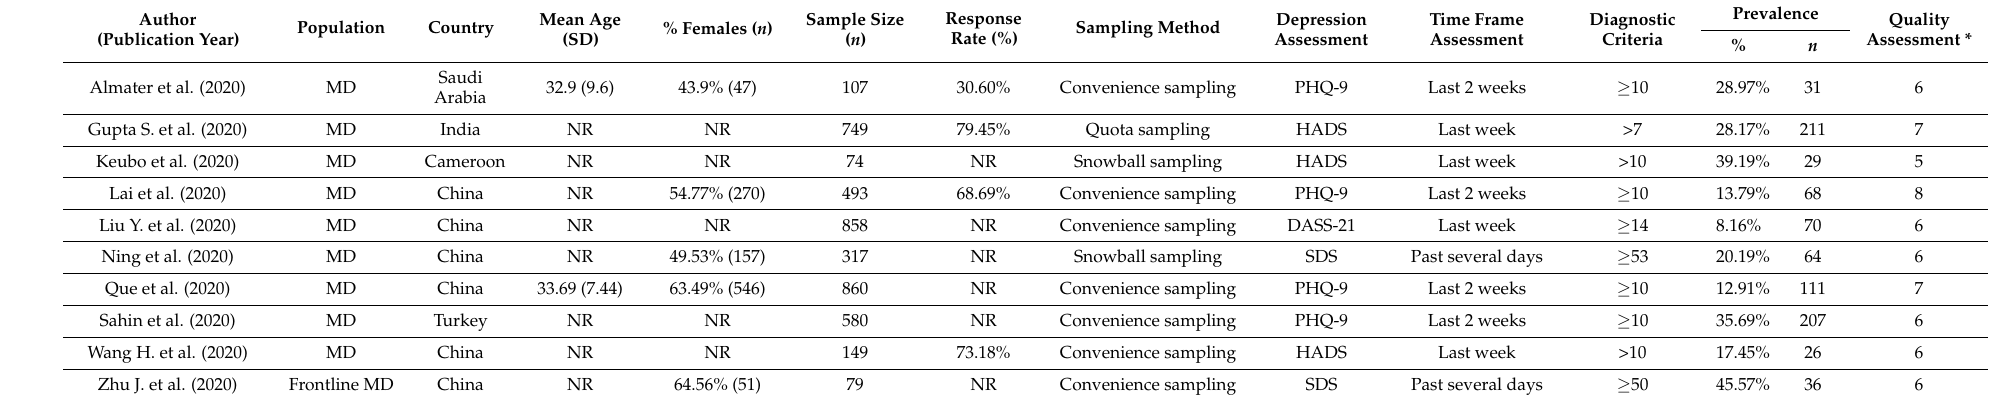
Table 3. Characteristics of the studies included in the meta-analysis based on samples of medical doctors.